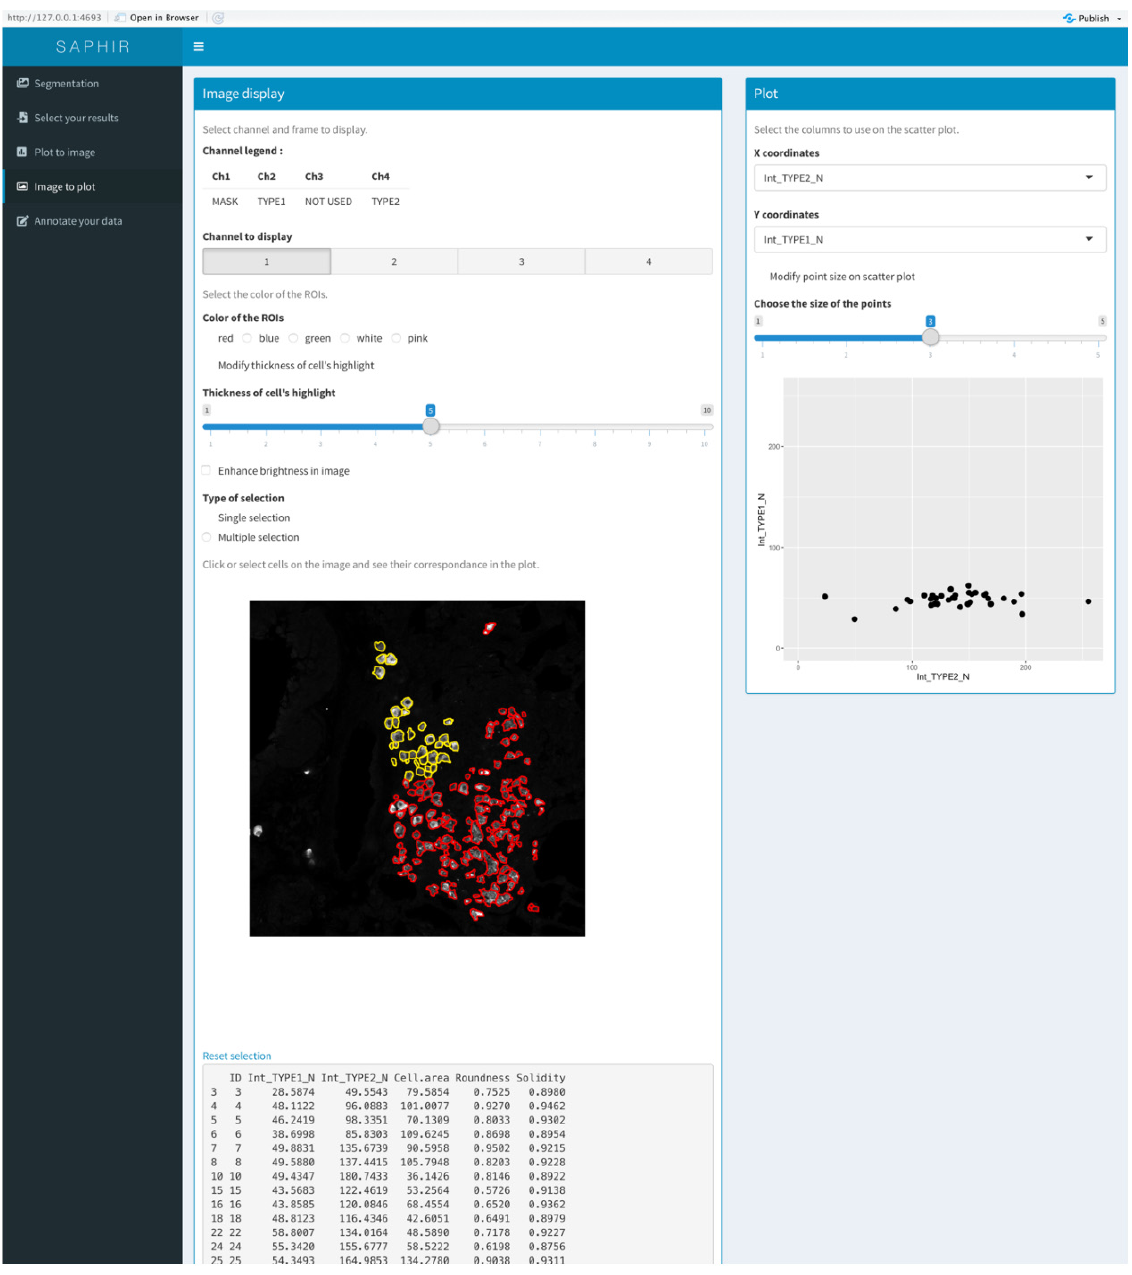
Figure 4. Menu “Image to Plot” of SAPHIR application. Selection of one region in the image (left) and visualization of COI of this region in a corresponding scatterplot where two parameters are displayed (right).